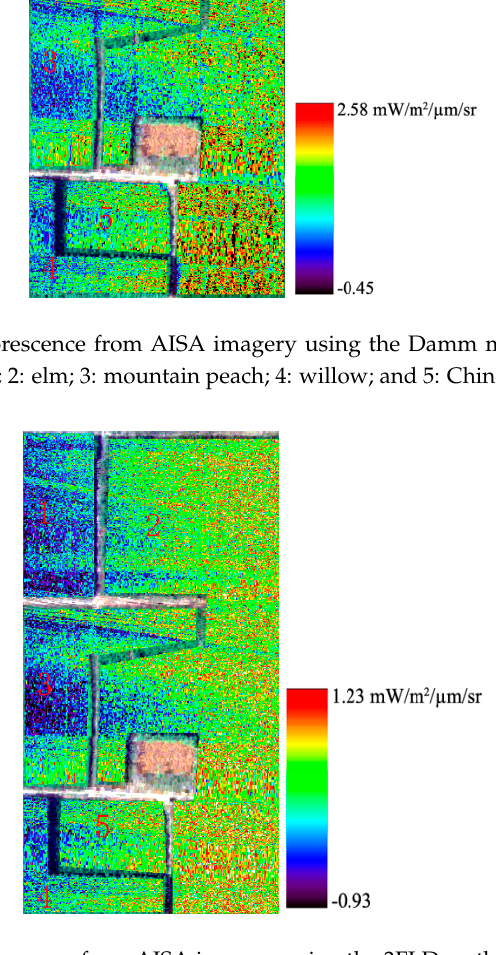
Figure 7. Retrieved fluorescence from AISA imagery using the 3FLD method; 1: ailanthus; 2: elm; 3: mountain peach; 4: willow; and 5: Chinese ash.